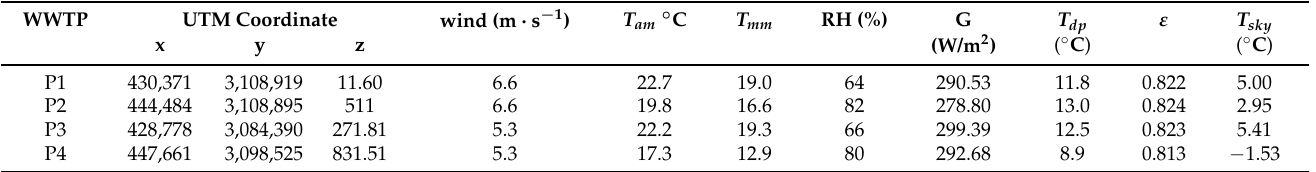
Table 4. Specific weather parameters considered from four wastewater treatment plants (WWTP). It is provided the Universal Transverse Mercator (UTM) coordinates. T am are the annual means temperatures and T mm the monthly means. P1 and P3 are located in the coastal zones, while P2 and P4 are located in the mid-altitude zones.